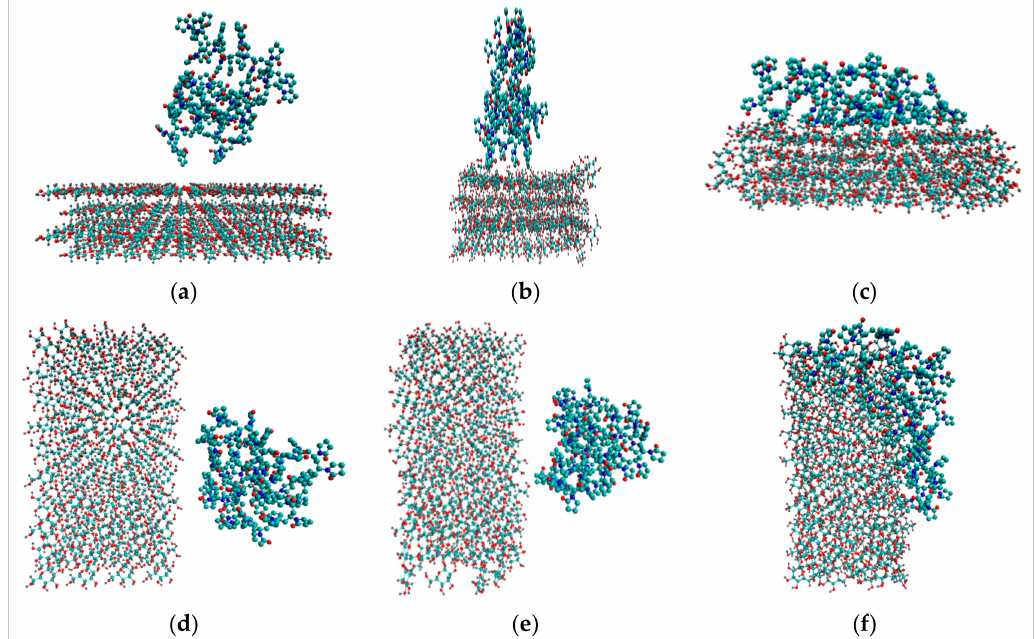
Figure 2. Initial configurations of system 3 ( a ) and system 5 ( d ). Snapshots of the last frames of system 3 ( b ) and system 5 ( e ), system 4 ( c ) and system 6 ( f ). All the water molecules were deleted to